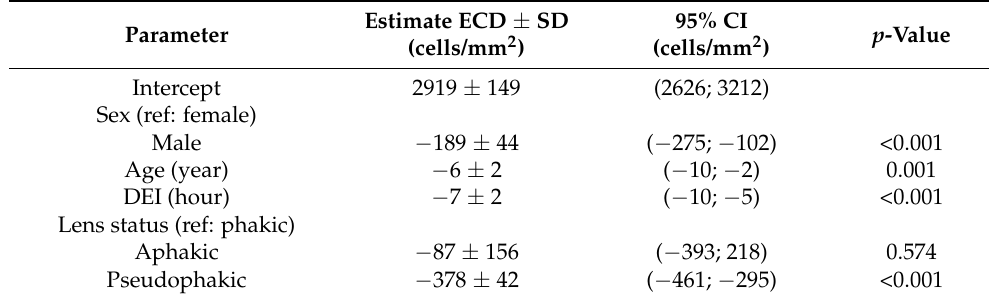
Table 7. Association analysis of ECD with ocular and donor characteristics. Linear regression analysis using a mixed